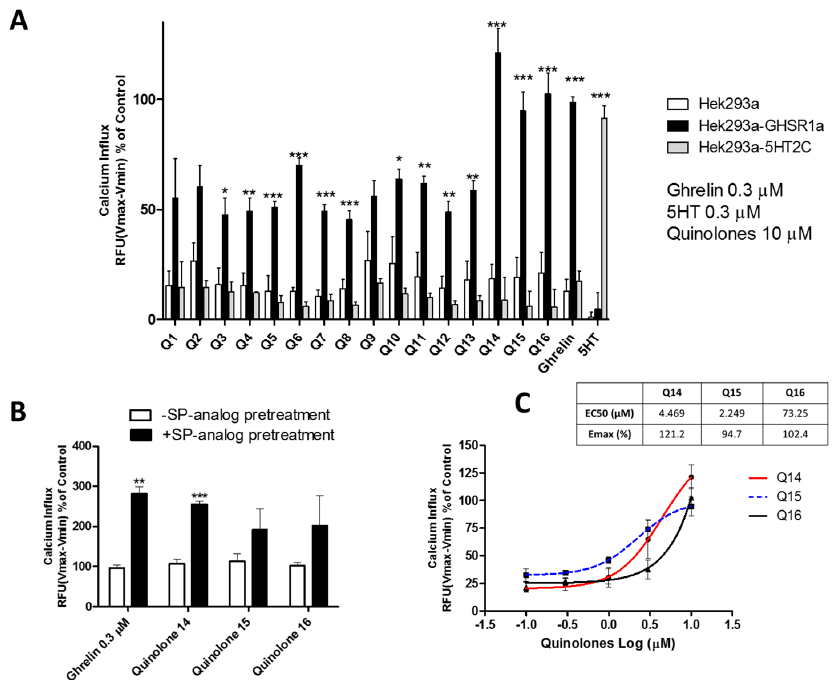
Figure 3. Quinolone compounds (10 µM) specifically activate intracellular calcium influx in Hek-GHS-R1a-EGFP cells. ( A ) Quinolones effects on intracellular calcium influx in wild-type Hek cells. Hek cells stably overexpress the GHS-R1a and Hek cells stably overexpress the 5HT2C receptor. ( B ) Quinolones induced GHS-R1a activation was enhanced following attenuation of constitutive receptor activity by pre-treatment with the GHS-R1a inverse agonist, [D-Arg1, D-Phe5, D-Trp7,9, Leu11]-substance P (1 µM, SP-analogue), ( C ) Quinolones dose-response curve on the intracellular calcium influx in Hek cells stably overexpressing the GHS-R1a. Graphs represent the mean ± SEM from at least four independent experiments with each sample performed in triplicate. The intracellular calcium increase was depicted as a percentage of maximal calcium increase as elicited by the control (3.3% FBS). Significant differences are presented by * indicating p ≤ 0.05, ** indicating p ≤ 0.01 and *** indicating p ≤ 0.001. For further statistic details, see the methods section.